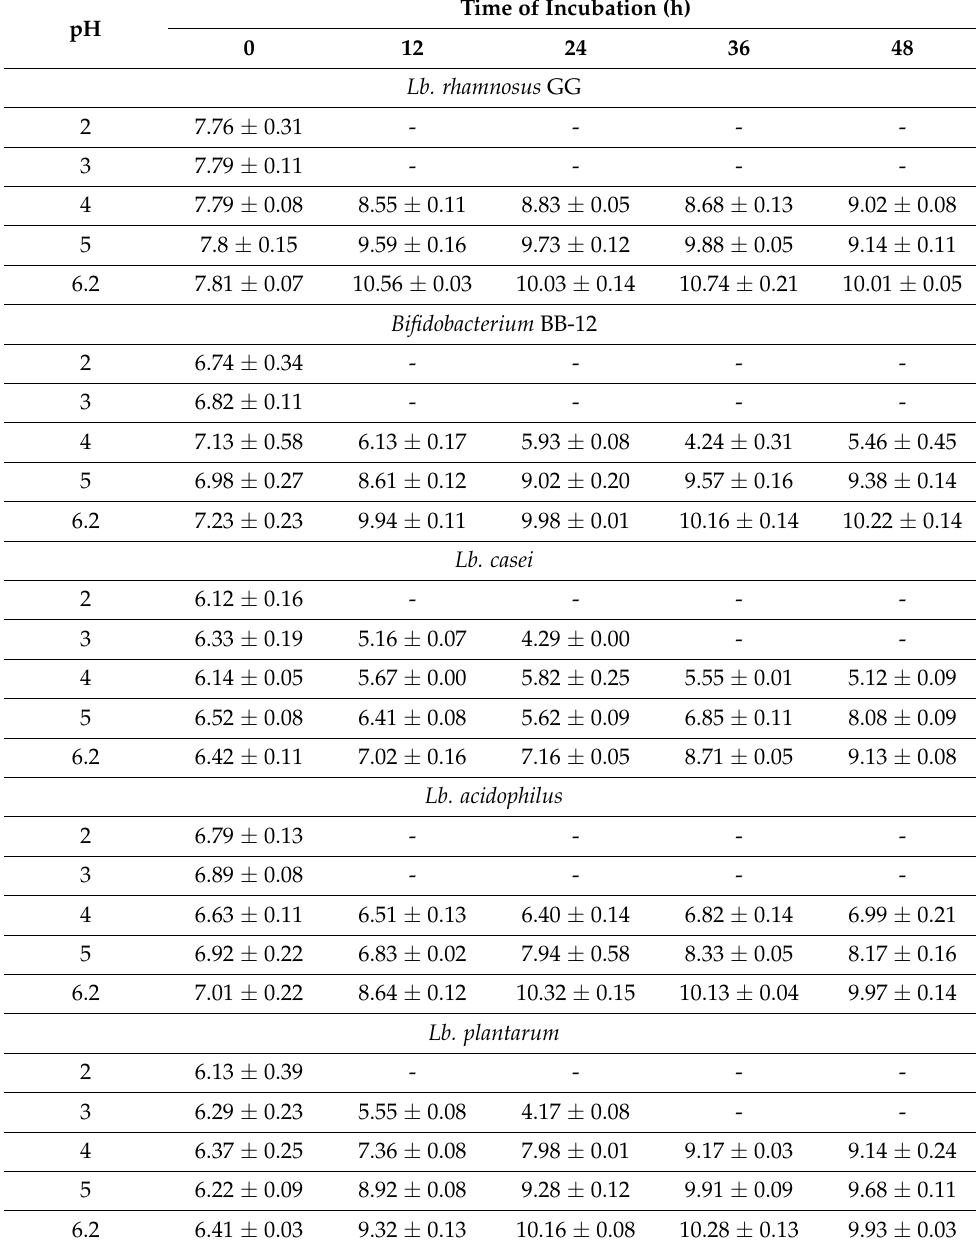
Table 1. Growth of commercial probiotic strains (log CFU mL − 1 ± SD) in MRS medium with different